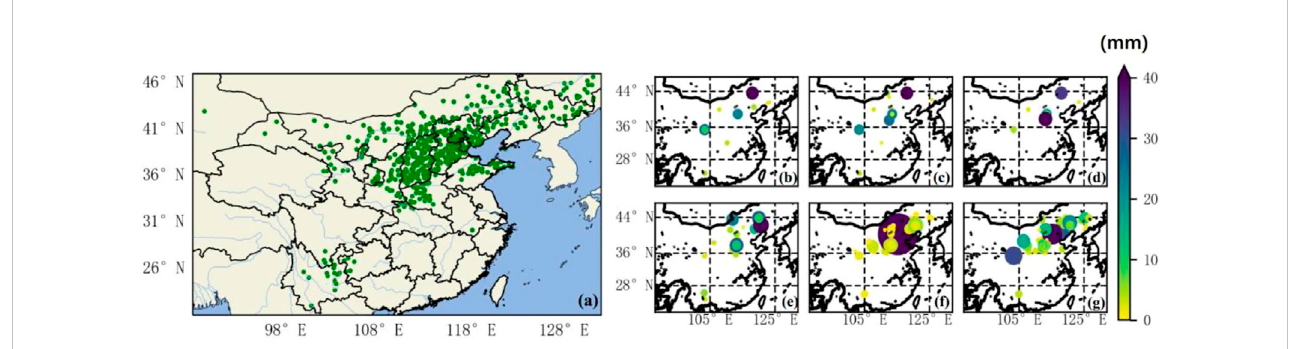
FIGURE 8 (A) Datapointdistributionplotwithrelativehumidityoflessthan30%.Thehourlyrainfallintensitydistributionmapforthedatapointsin (A) : (B) rainfallfor the fi rst 3 hours; (C) rainfall for the fi rst 2 hours; (D) rainfall the previous hour; (E) rainfall in the next hour; (F) rainfall in the next 2 hours; (G) rainfall in the next 3